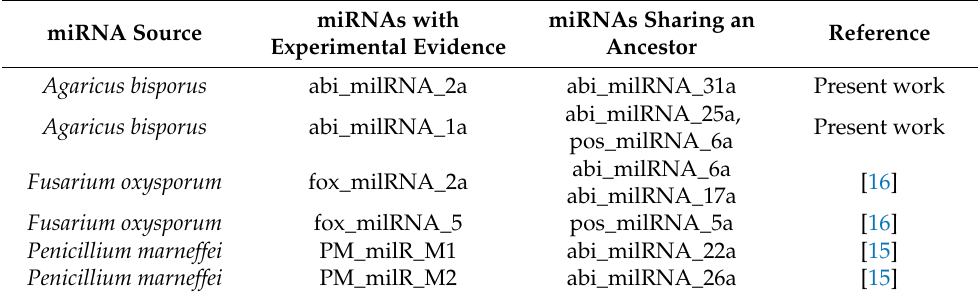
Table 3. Fungal miRNAs with experimental evidence and their potential orthologues. miRNAs with miRNAs Sharing an miRNA Source Experimental Evidence Ancestor